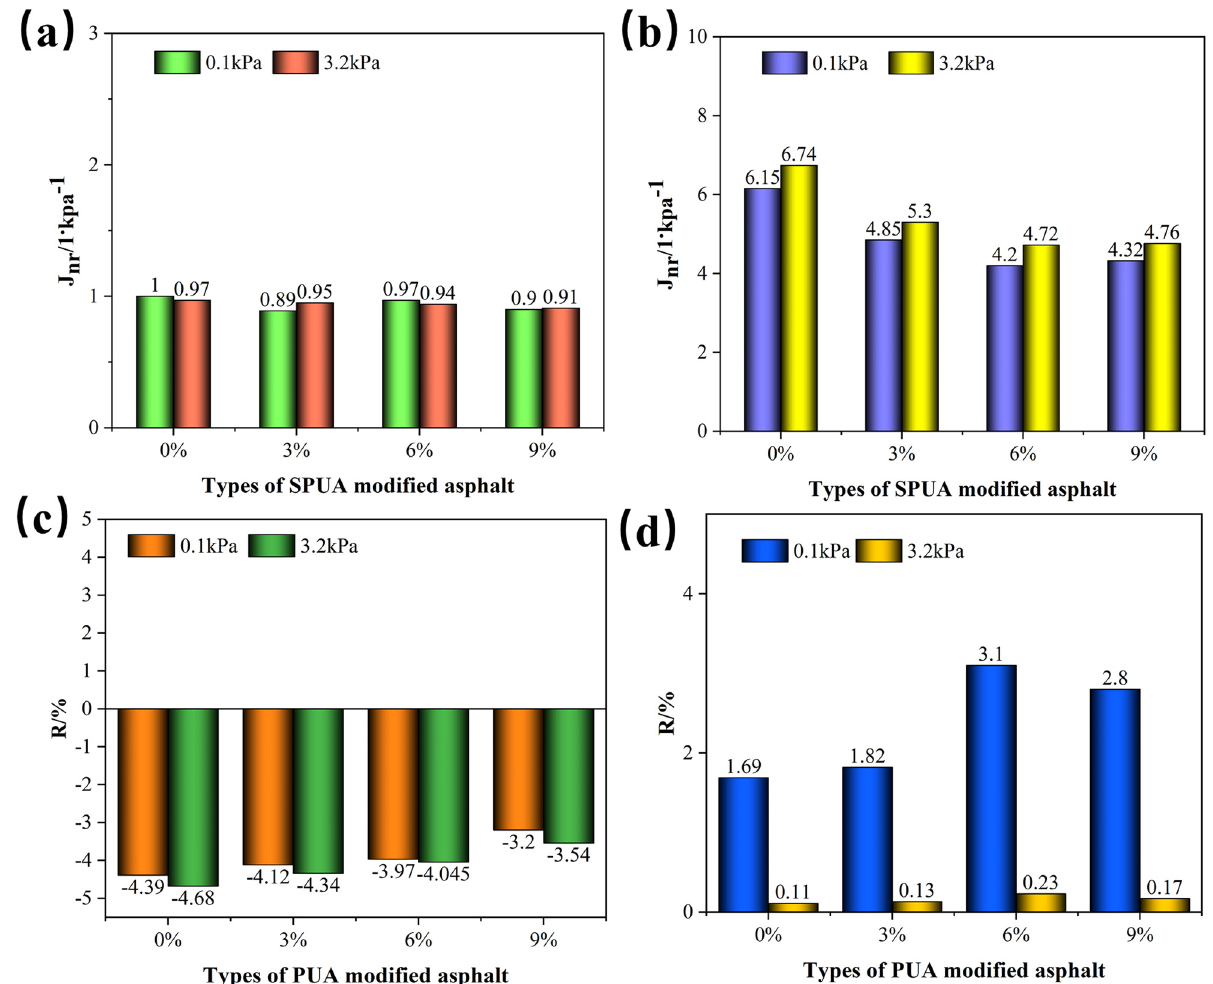
Figure 5: Unrecoverable creep compliance and creep recovery rate of asphalt under di ff erent parallel plates: ( a ) Jnr under 8 mm parallel plate, ( b ) Jnr under 25 mm parallel plate, ( c ) R under 8 mm parallel plate, and ( d ) R under 25 mm parallel